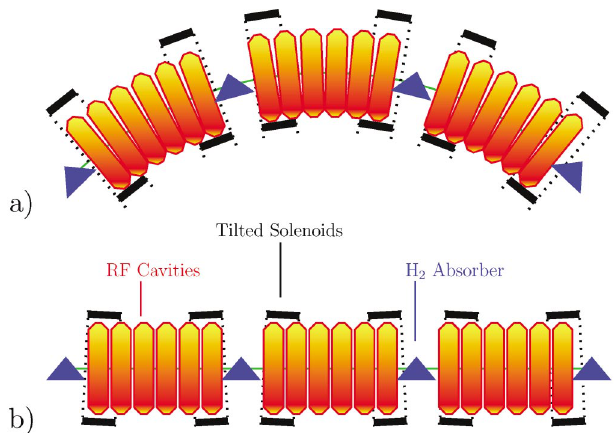
FIG. 2. (Color) Three cells of the RFOFO lattice; (a) top view; (b) side view. Notice that the coils have been displaced radially by 10 cm.